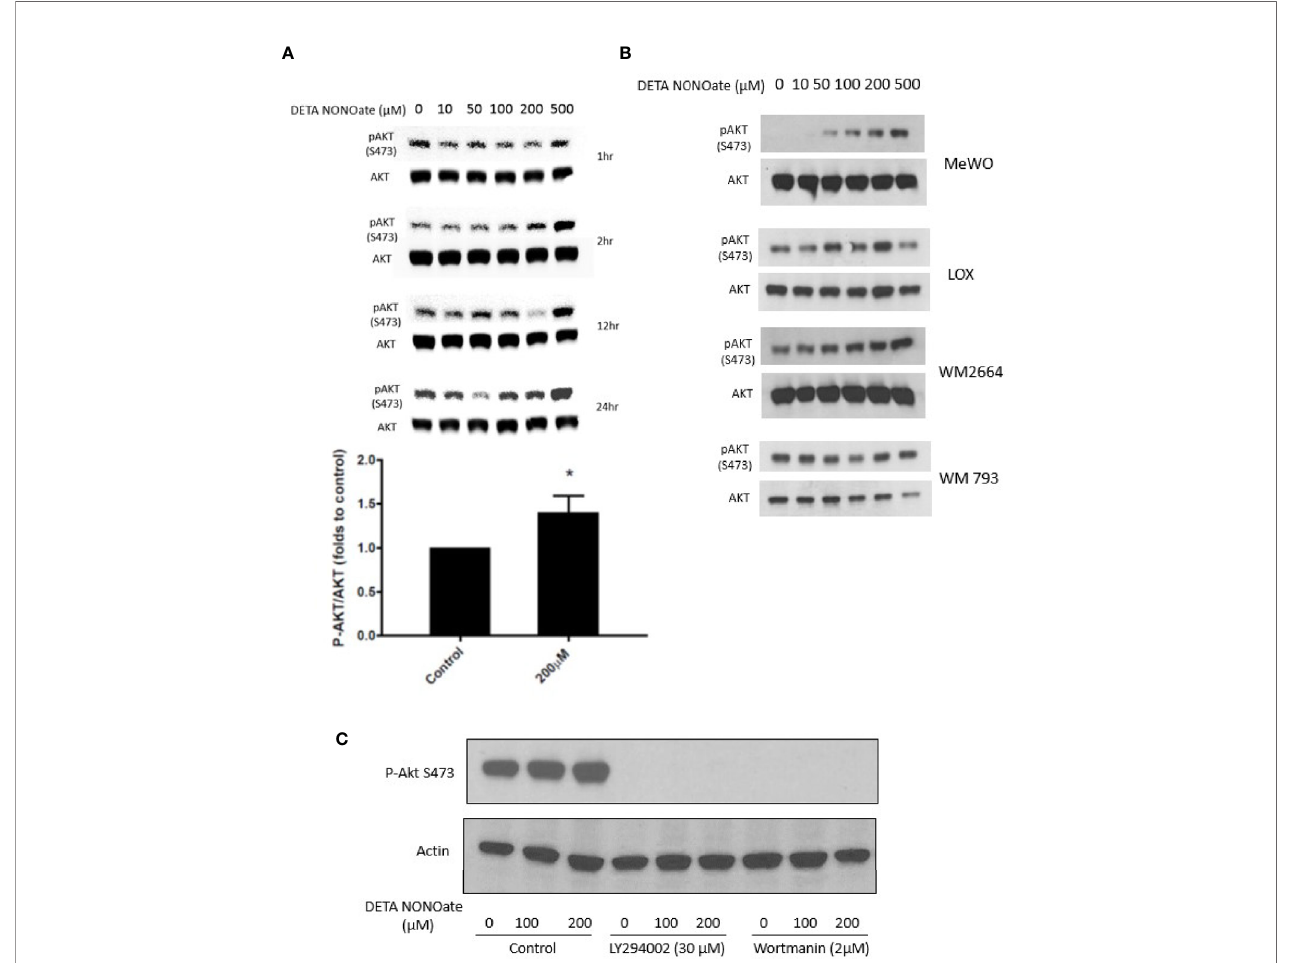
FIGURE 2 | Nitric oxide stimulates PI3K and activates AKT in melanoma cells. (A) A375 cells were treated with NO donor DETA NONOate (0 – 500 µM) for 1, 2, 12, and 24 h. P-Akt (S473) levels were examined by western blot. At 2 h, 200 µM DETA NONOate treatment signi fi cantly increased P-AKT (S473) level. (B) MeWo, LOX, WM 266-4, and WM 793 cells were treated with DETA NONOate (0-500 µM) for 2 h P-AKT (S473) expression was examined by western blot. (C) PI3K inhibitor LY294002 and Wortmann pretreatment both blocked basal and NO-induced P-AKT(S473)